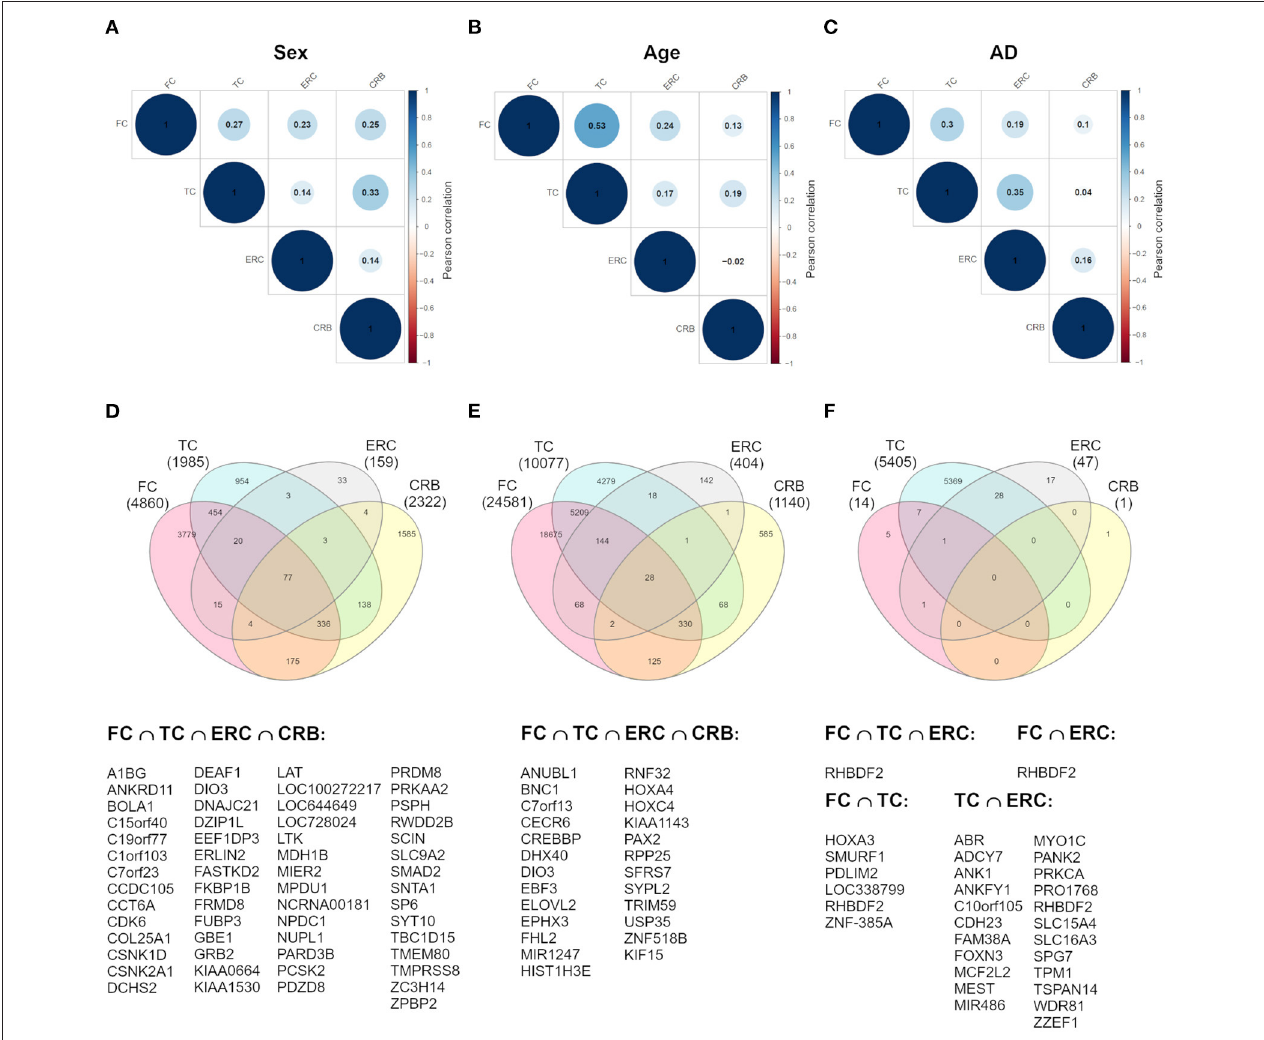
FIGURE 2 | Cross-region analysis of sex-, age-, and AD-associated probes. (A–C) The correlation matrix plots show the magnitude of correlation among probes’ effect sizes in the four brain regions, considering the results of the meta-analysis on sex- (A) , age- (B) , and AD- (C) associated probes. Positive and negative correlation values are indicated in blue and red, respectively. (D–F) The Venn diagrams display the number of significant DMPs shared between the four brain regions, considering sDMPs (D) , aDMPs (E) , and AD-DMPs (F) . The genes in which the most shared probes map are reported below each